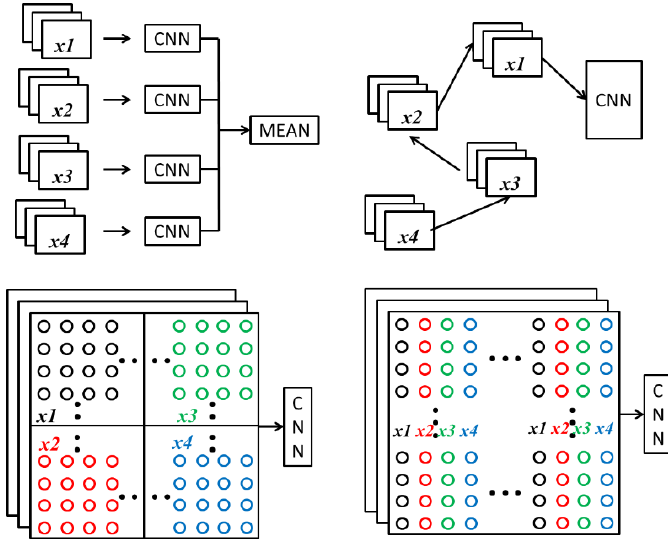
Figure 8. Dataset conversion methods, top left: Four inputs applied to the model respectively, top right: Four inputs applied to the model sequentially, the bottom ones: Four inputs rearranged to the image respectively and sequentially.